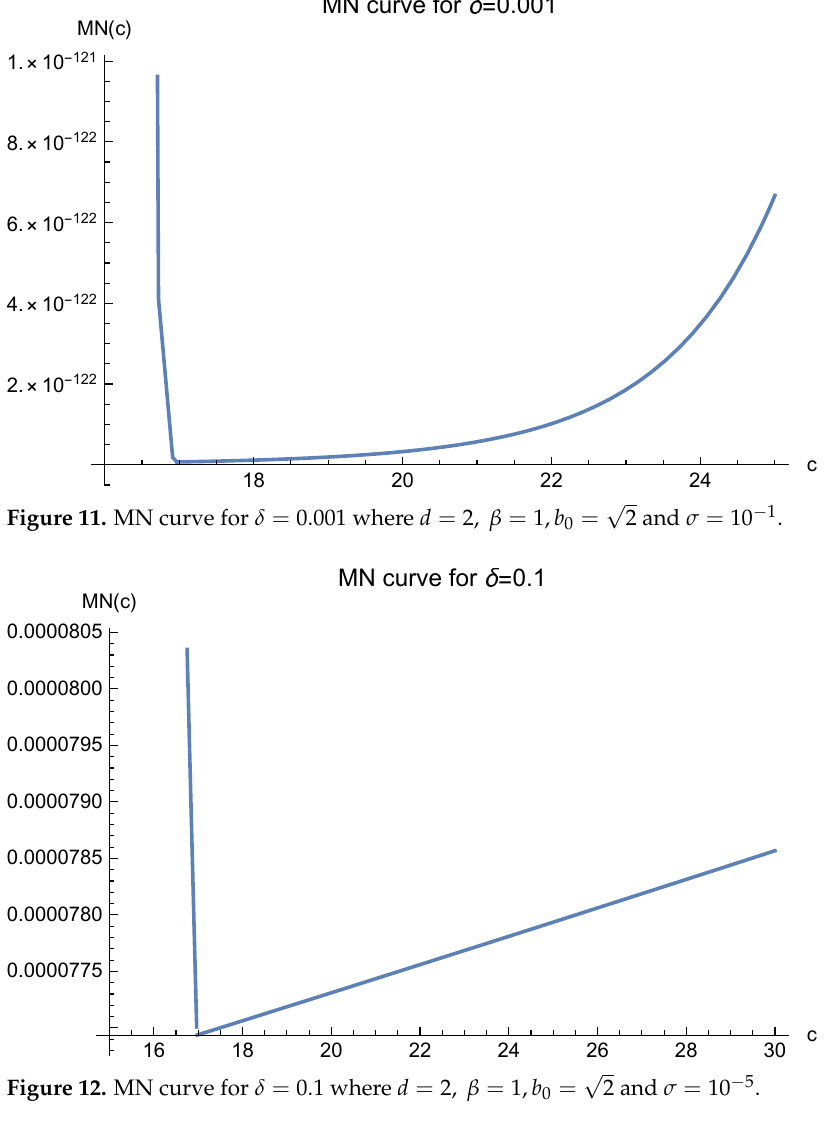
√ 2 and σ = 10 − 1 . MN curve for = 0.001 (cid:1)